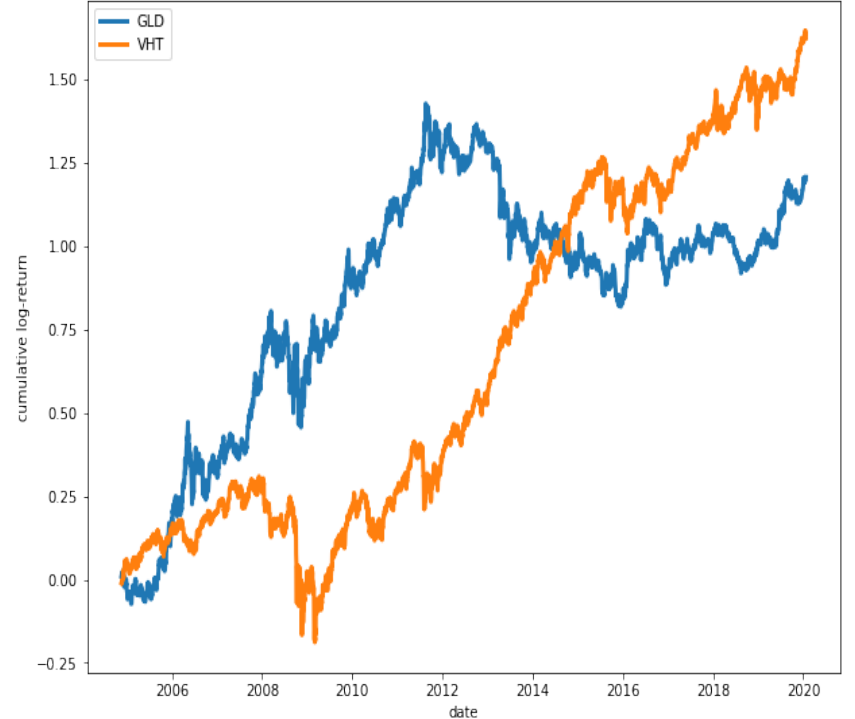
Figure 16. Cumulative log-returns of ETFs GLD and VHT. The degree of co-movement is low ( HP =